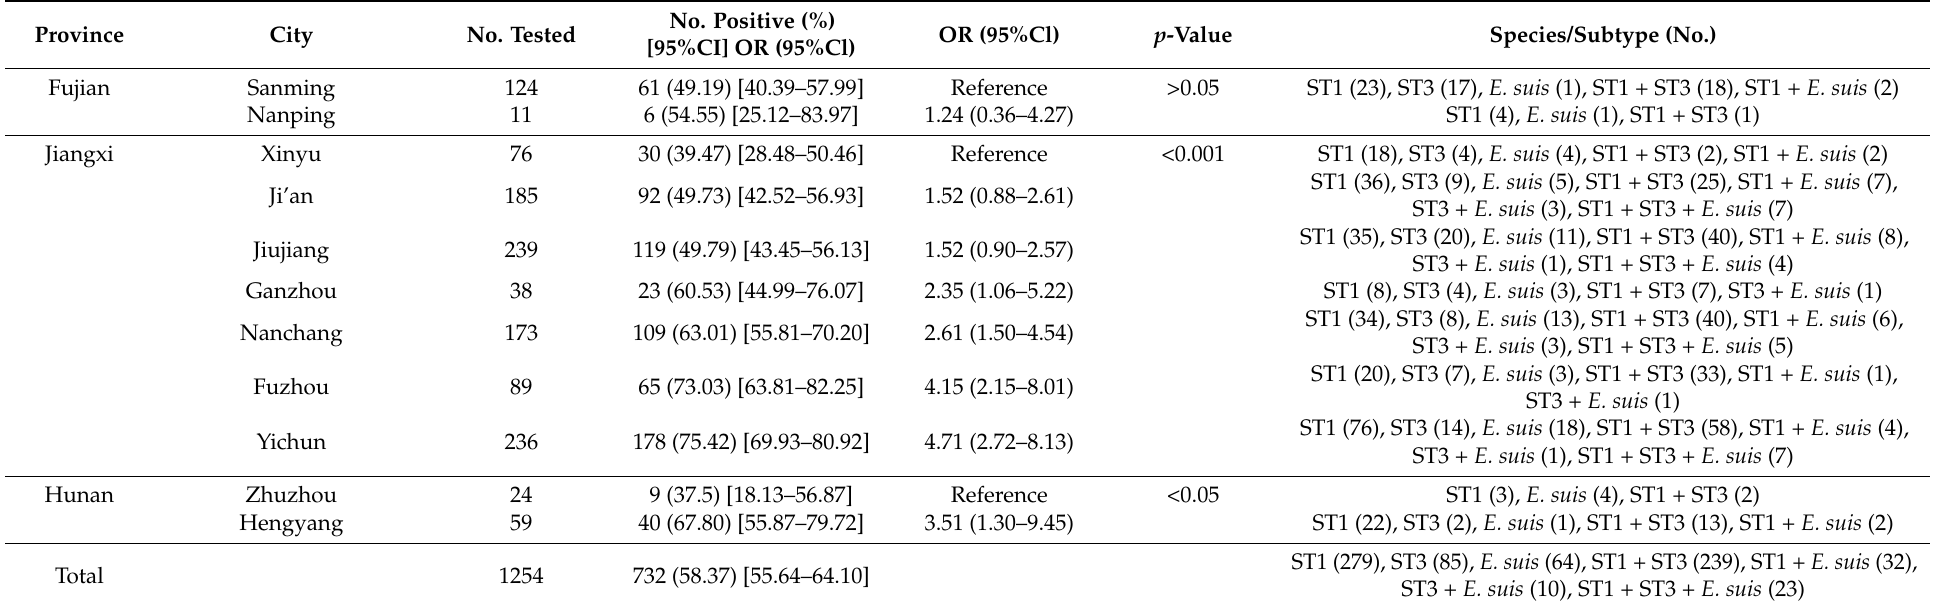
Table 3. Distribution of Entamoeba spp. in different sampling